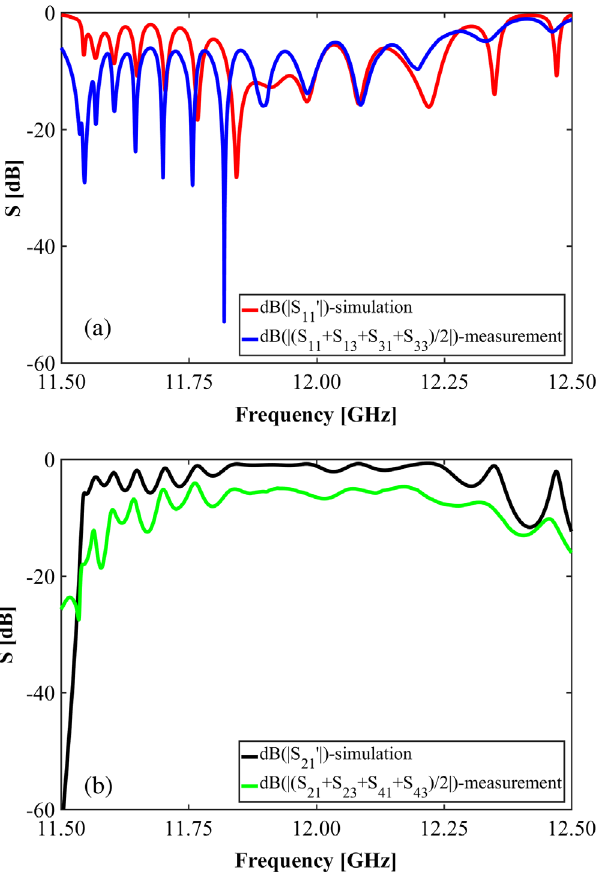
FIG. 29. Comparison between simulated and measured S parameters [(a) S 0 11 and (b) S 0 21 ] for the full-assembly structure ¼ 2 . 99 mm, W ¼ 2 . 08 mm at one side and W with R ¼ 1 in 1 2 . 12 mm at the other side, and an offset of 1.0 mm for the two- halves copper jacket in both horizontal ( x axis) and vertical ( y axis) directions, a microgap of 1.0 mm with an alignment angle β ¼ 45 o [see Fig.